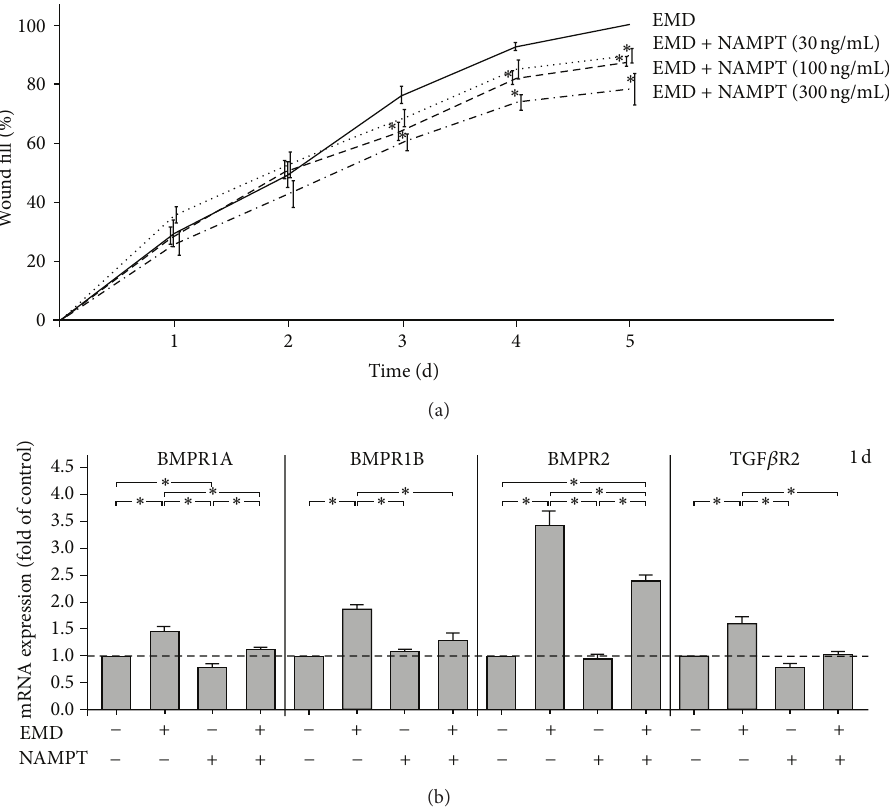
Figure 4: Effect of various concentrations (0, 30, 100, and 300 ng/mL) of NAMPT on the EMD-induced PDL cell wound fill rate (a). The wound closure, that is, the percentage of fill of the initially cell free zones created by wounding, were analysed over 5d. All experiments were performed in triplicate and repeated at least twice. Mean ± SEM ( 𝑛 = 12 ); ∗ significantly ( 𝑃 < 0.05 ) different from EMD-treated cells in the absence of NAMPT. Effect of EMD on the expression of BMPR1A, BMPR1B, BMPR2 and TGF 𝛽 R2 in the presence and absence of NAMPT (100ng/mL) at 1d (b). Untreated cells served as control. All experiments were performed in triplicate and repeated at least twice. Mean ± SEM ( 𝑛 = 18 ); ∗ significant ( 𝑃 < 0.05 ) difference between